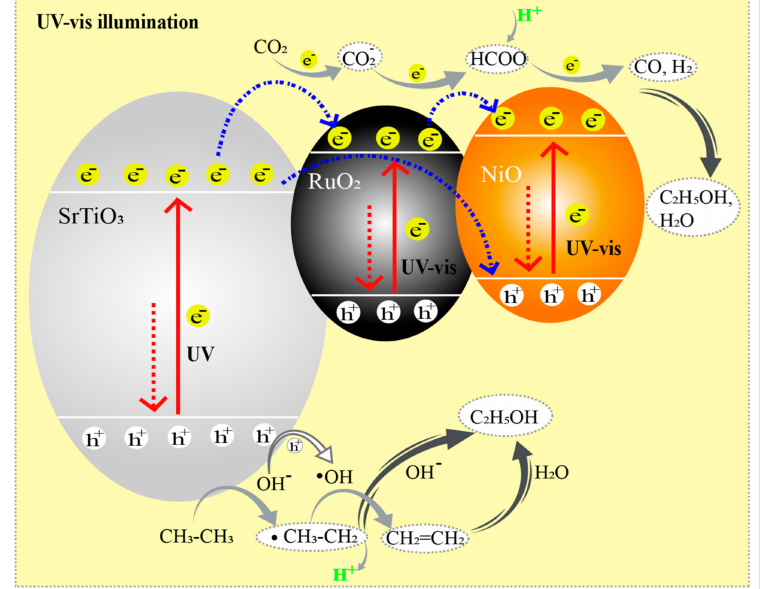
Figure 11. Possible reaction pathway and mechanism towards ethanol production, from CO 2 and C 2 H 6 , on the surface of the hybrid SrTiO 3 :RuO 2 :NiO catalyst, by means of solar-driven heterogeneous